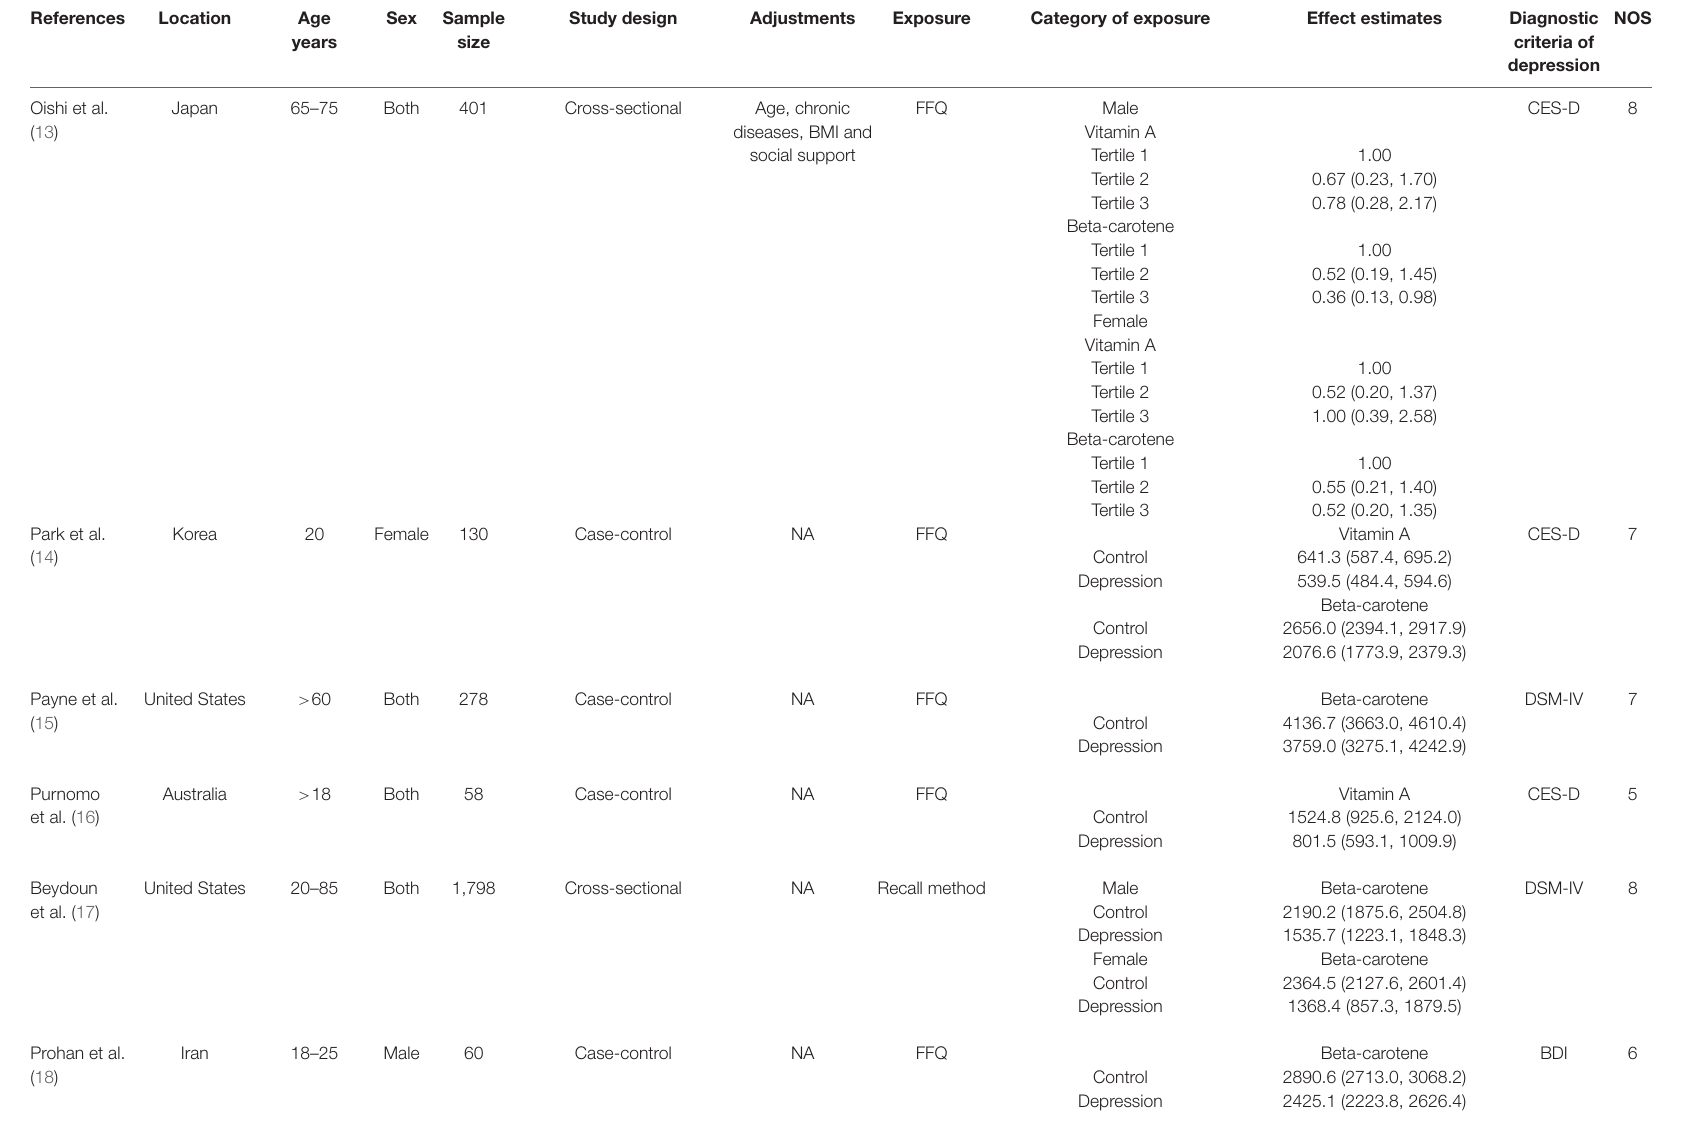
TABLE 1 | Characteristics of the individual studies included in this